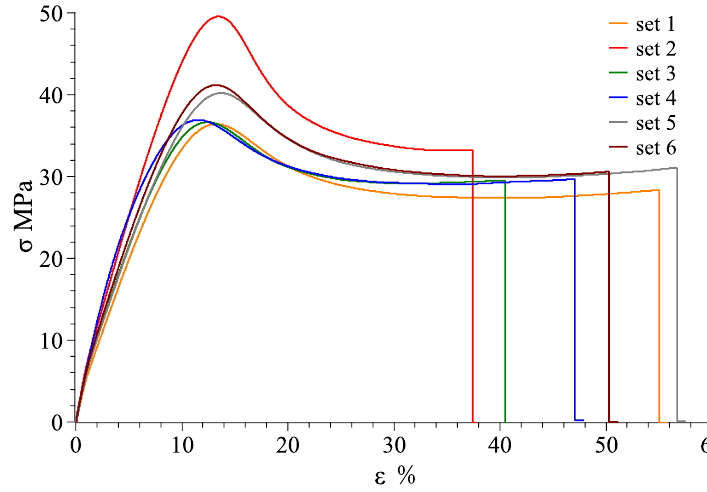
Figure 26. VeroWhitePlus, DM8510 stress–strain curve for the X-axis (6 specimens). When two materials were combined symmetrically along the Y-axis, the stress-strain curve was